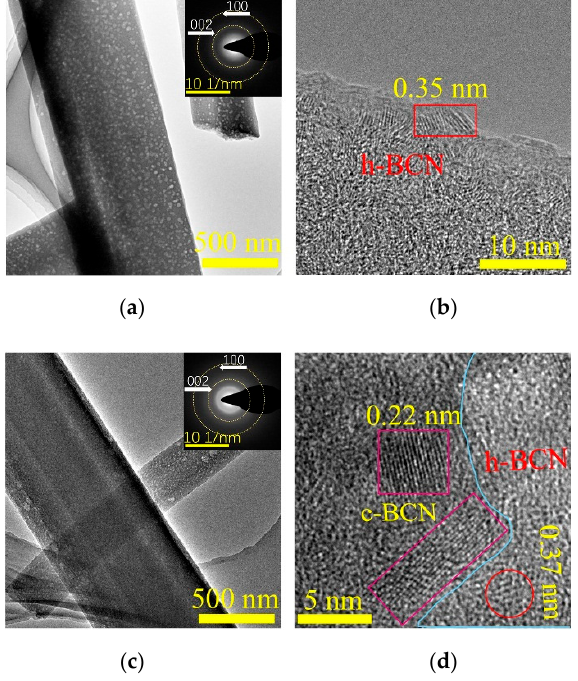
Figure 3. ( a ) TEM and ( b ) HRTEM images of p-BCN-1, inset of ( a ): selected area electron diffraction (scale bar: 500 nm and 10 nm). ( c ) TEM and ( d ) HRTEM image of p-BCN-2 (scale bar: 500 nm and 10 nm). ( c ) TEM and ( d ) HRTEM image of p-BCN-2 (scale bar: 500 nm and 5 (scale bar: 500 nm and 5 nm).